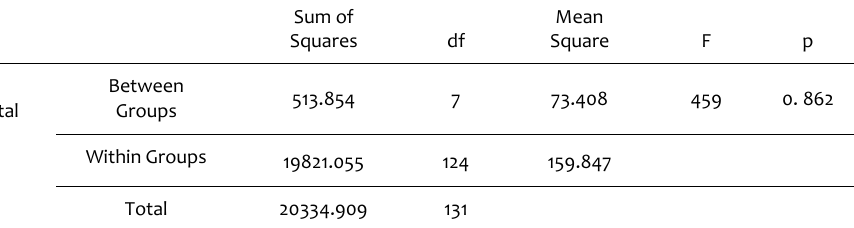
Table 15. Students' reading motivation scores in relation to number of